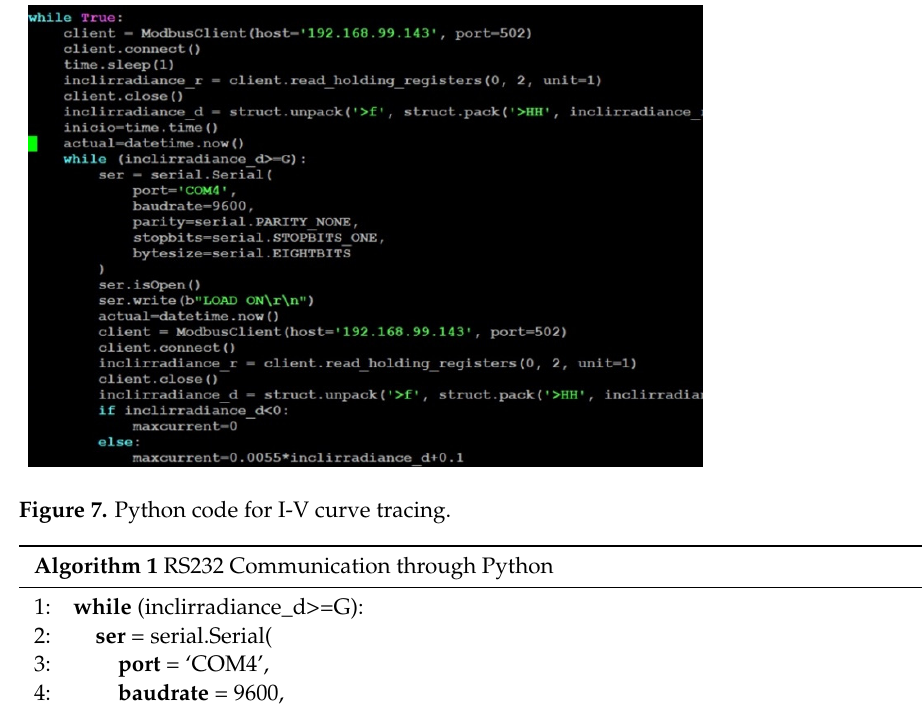
Figure 6. Data taken during characterization of PV modules.